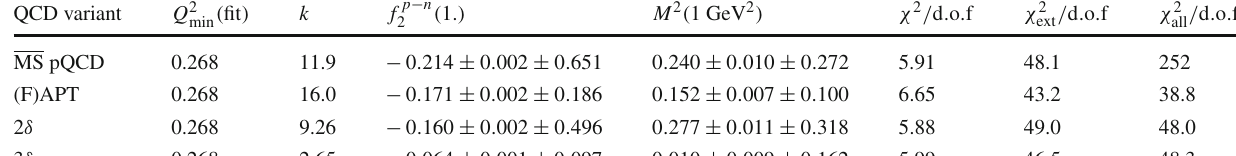
Table 4 As in Table 3, but now the squared mass in the higher-twist term in Eq. (16) is running according to Eq. (17) QCD variant